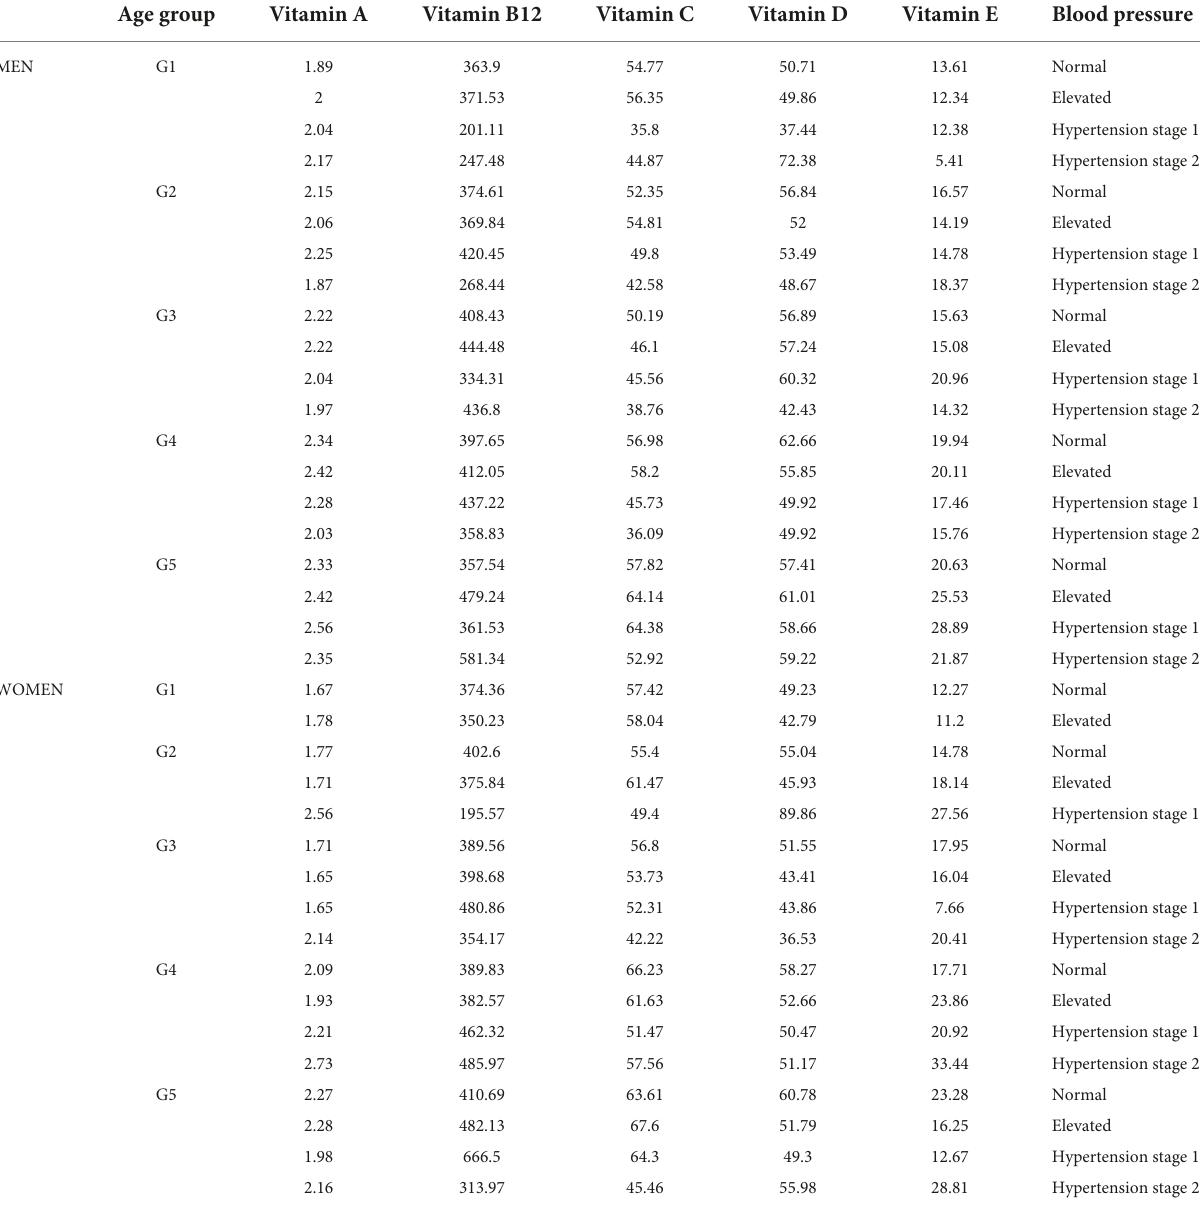
TABLE 2B Mean serum concentration of vitamin A ( µ mol/L), B12 (pmol/L), C ( µ mol/L), D (nmol/L), and E ( µ mol/L) concentrations stratified by age group and blood pressure in women. Age group Vitamin A Vitamin B12 Vitamin C Vitamin D Vitamin E Blood